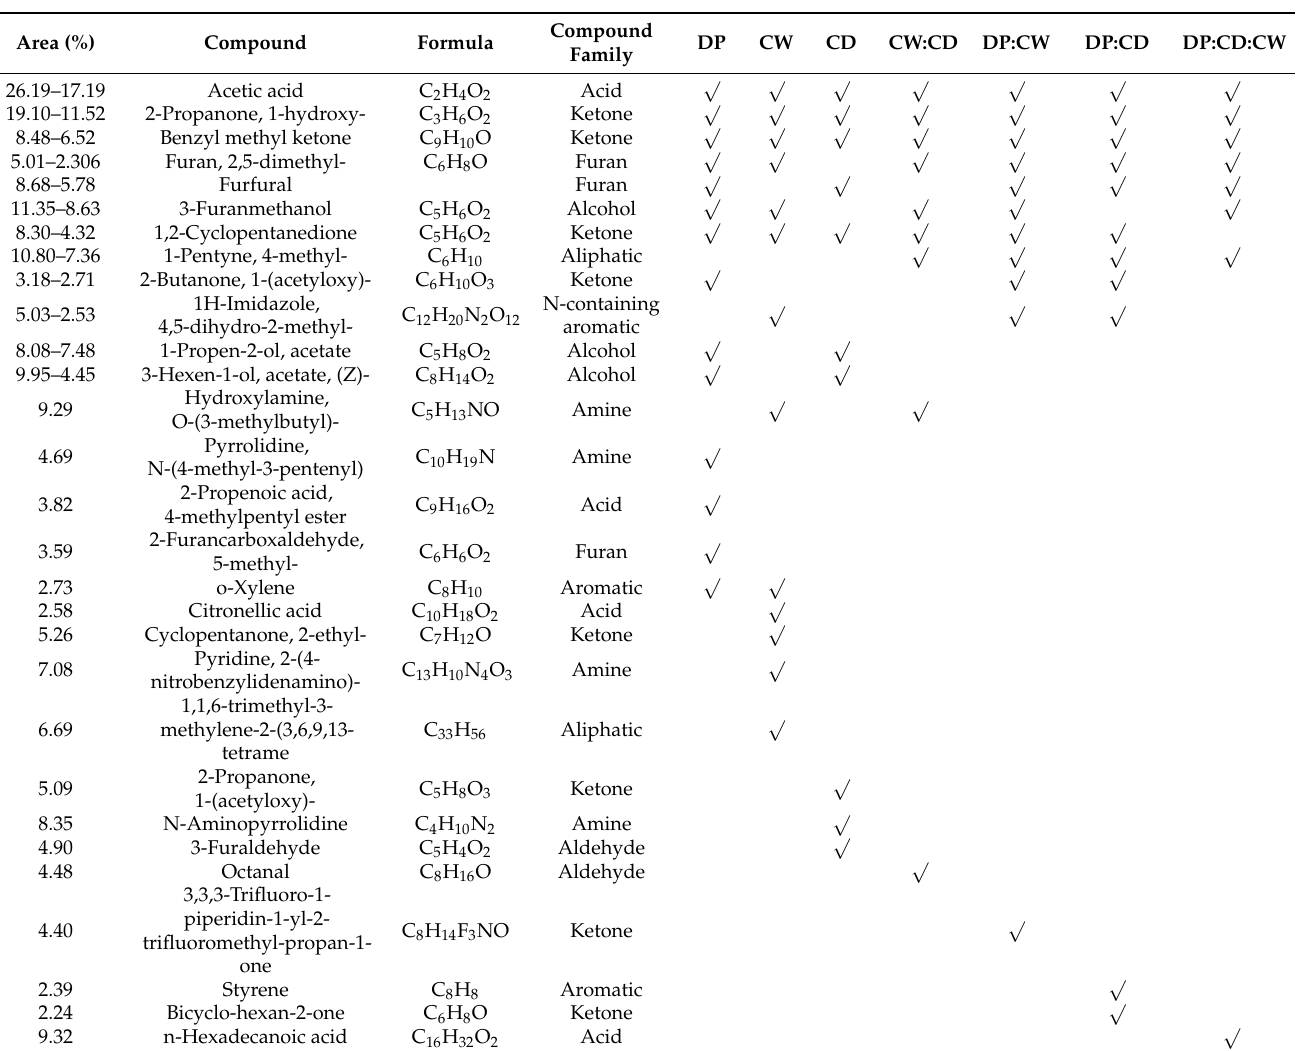
Table 3. Identified bio-oil compounds and family for the different feeds during fast